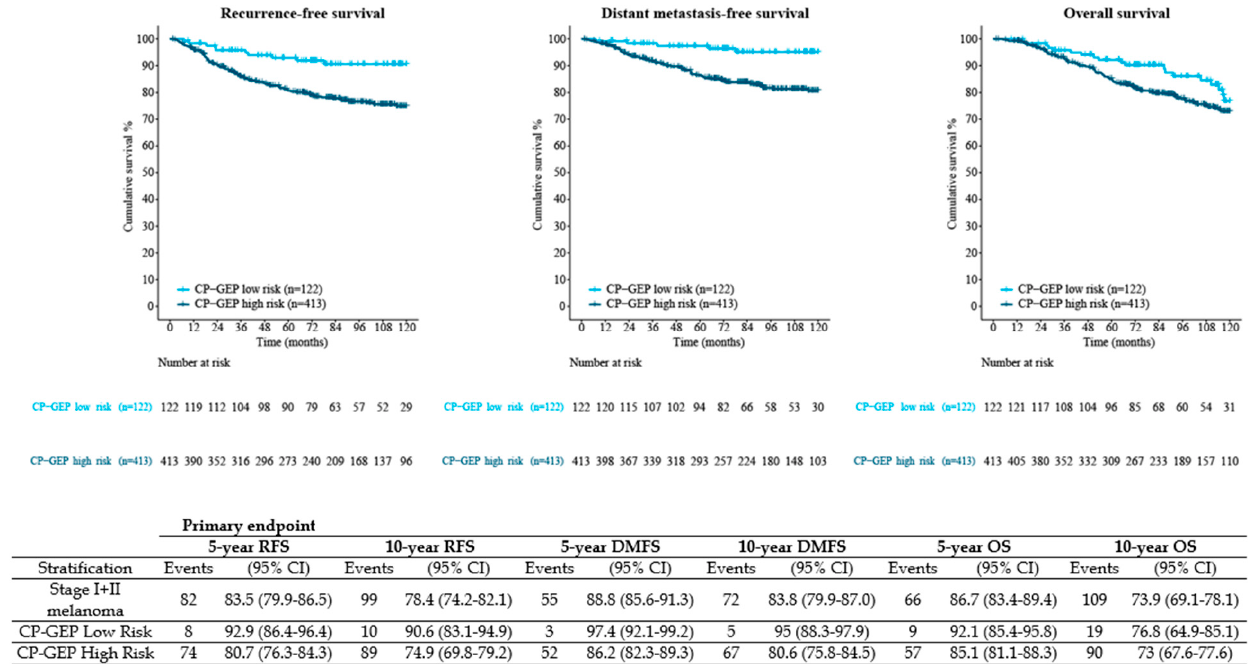
Figure 1. Kaplan–Meier survival curves (RFS, DMFS, and OS) stratified by CP-GEP classification. Table S1. A detailed overview of 5-year survival rates (RFS, DMFS, OS) in different (sub)stages in the Primary endpoint is 5-year RFS. CP-GEP, clinicopathologic and gene expression profile; DMFS, European cohort (Sahlgrenska University Hospital, Erasmus MC Cancer Institute, and combined). CP-GEP, distant metastasis-free survival; HR, hazard ratio; OS, overall survival; RFS, recurrence-free survival; clinicopathologic and gene expression profile; RFS, recurrence-free survival; SLNB, sentinel lymph node SLNB, sentinel lymph node biopsy; 95% CI, 95% confidence interval. biopsy; 95%CI, 95% confidence interval. According to the EORTC nomogram, 25% of the patients were classified as having a